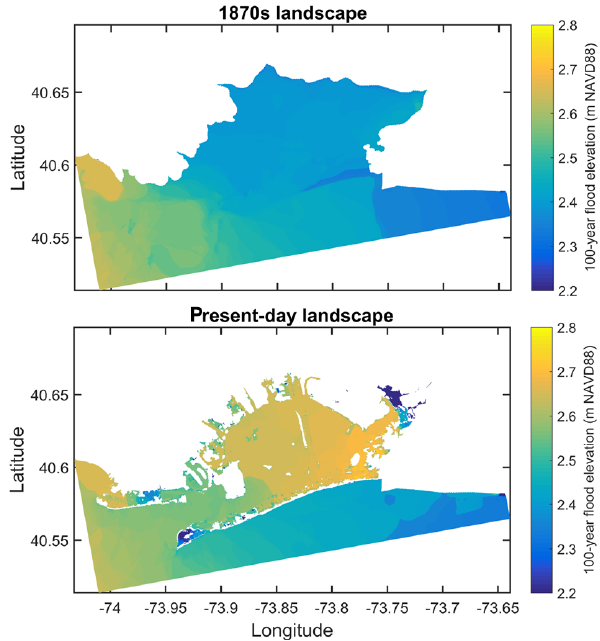
Figure 7. Maps of the 100-year flood for the present-day and 1870s landscapes. In both cases, floods were simulated with a 2016 mean sea